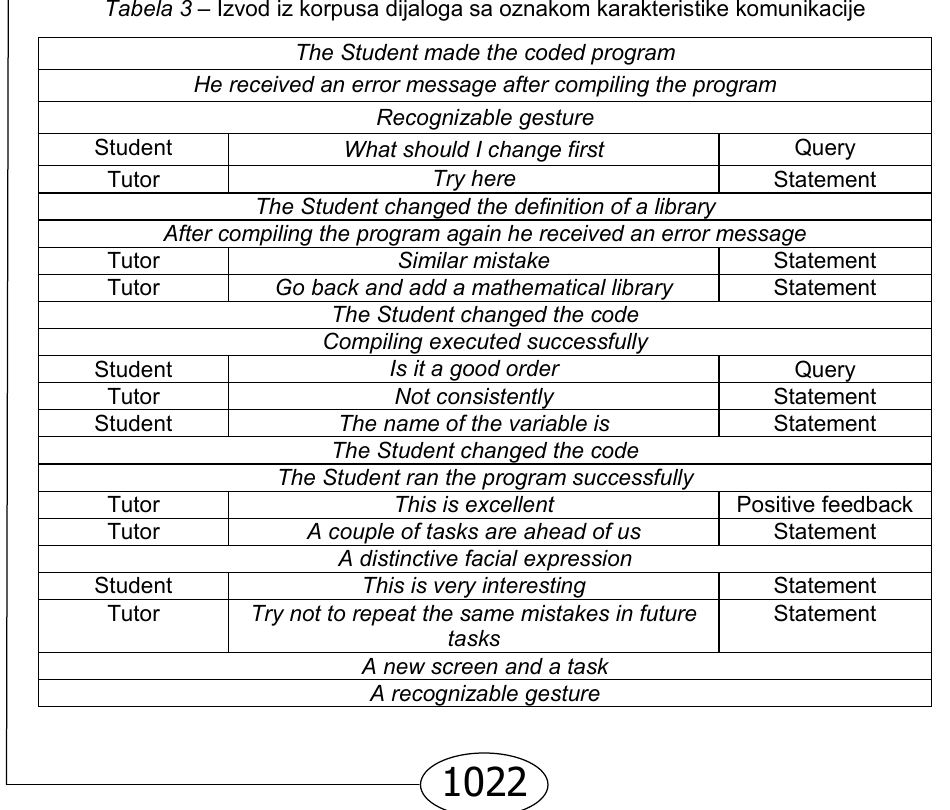
Table 3 – Excerpts from the corpus of dialogues with the tag: characteristics of communication Таблица 3 – Выборка из корпуса диалогов с обозначенными характеристиками